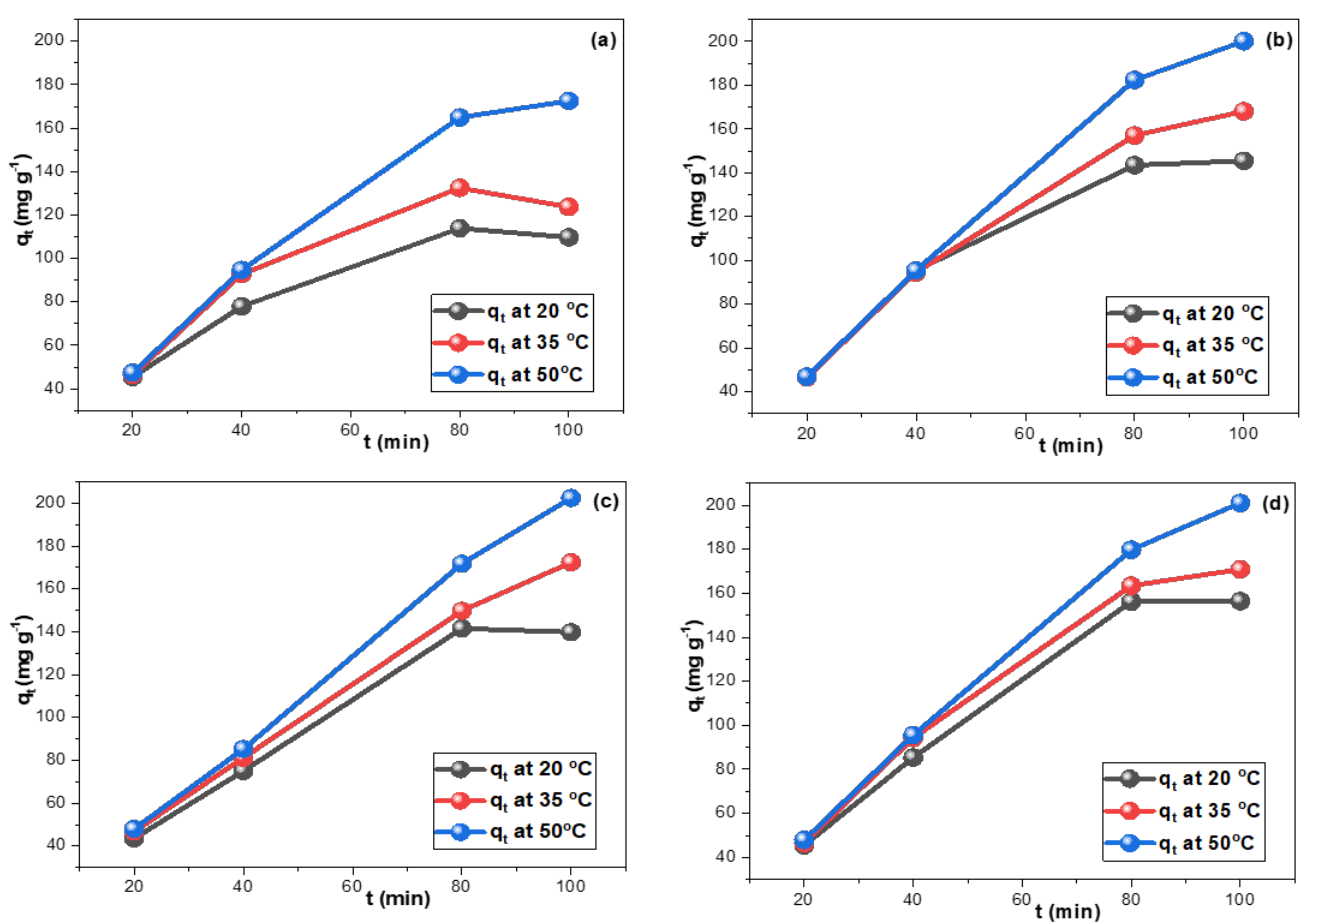
Figure 4. The impact of solution feeding concentration on the drug adsorption by the synthesized CRNPs at 20 °C, 35 °C, 50 °C for ( a ) TGCN, ( b ) DXCN C, ( c ) CTCN, and ( d )